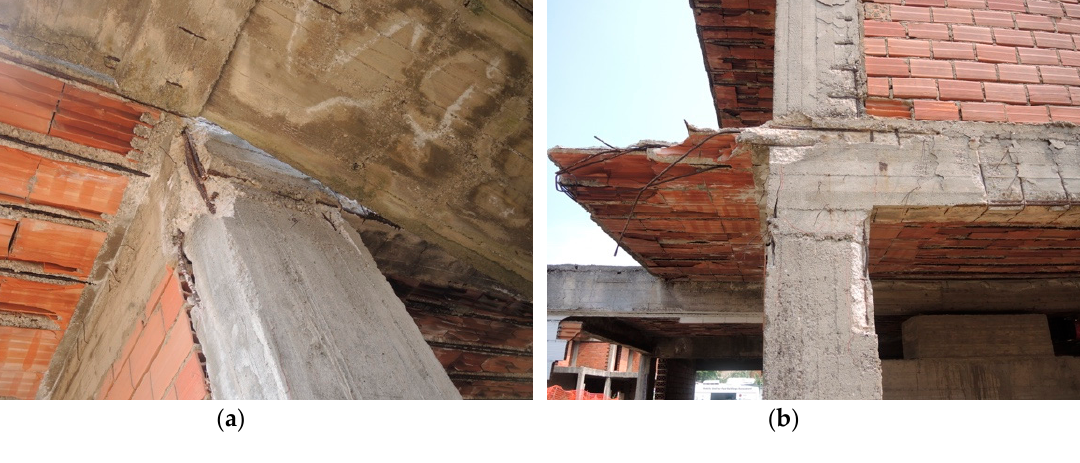
( b ) Figure 22. Force-displacement loop of individual actuators. Force is in the test direction, displacement is parallel ( a ) and orthogonal to the test direction ( b ).